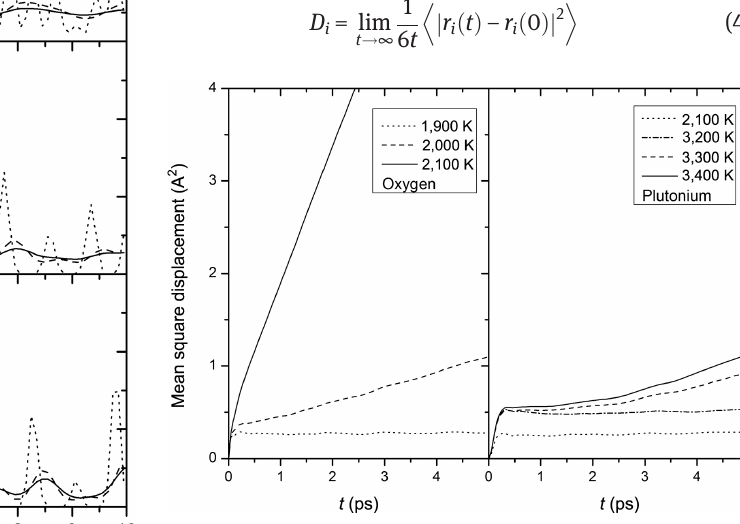
Figure 4: Mean square displacement versus time at different